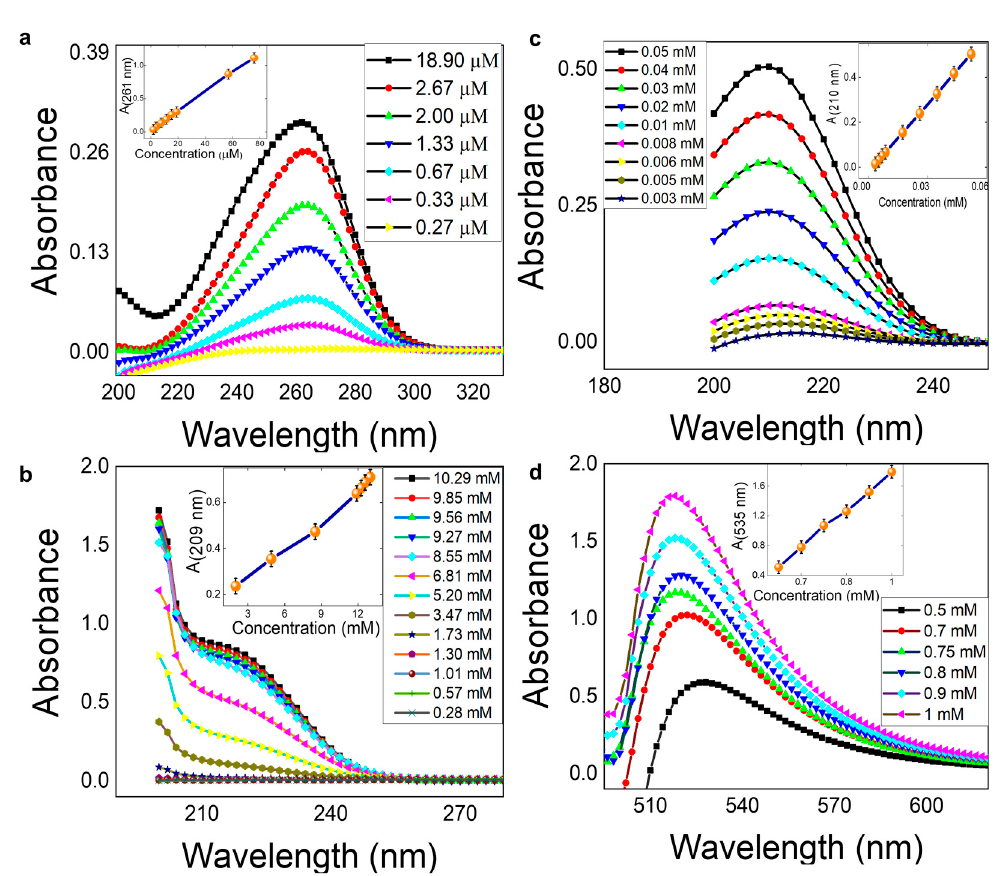
Figure 6. Absorbance Profile and Standard Curve. ( a ) Ascorbic acid; ( b ) nitrite; ( c ) citric acid; ( d ) glucose.